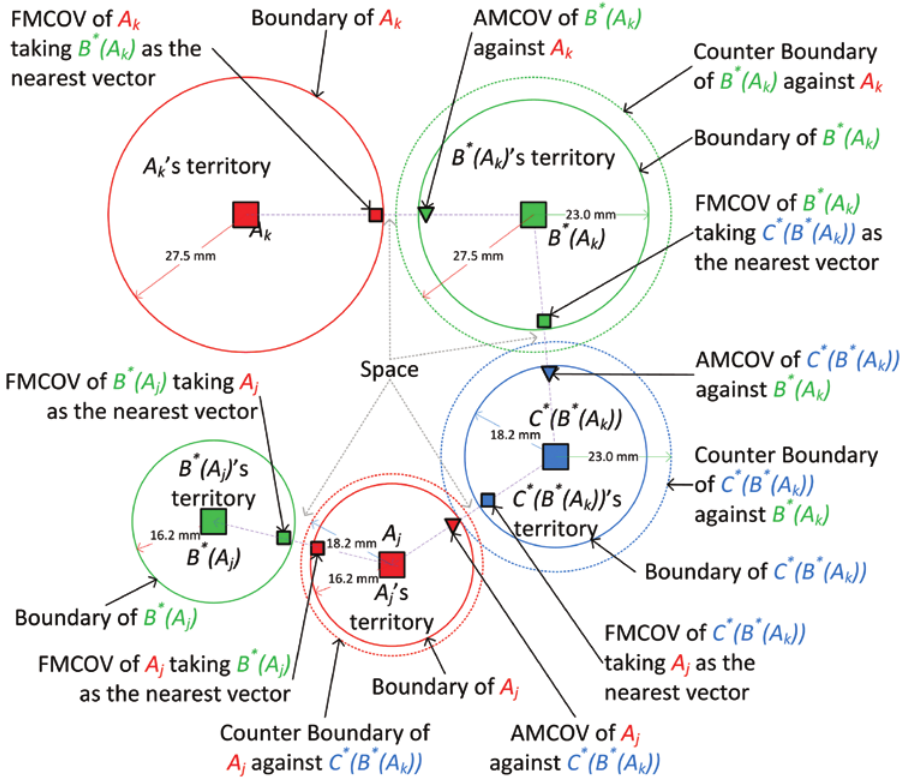
Figure 2: FMCOVs, AMCOVs, and Instance’s Territory in a Two-Dimensional Three-Class